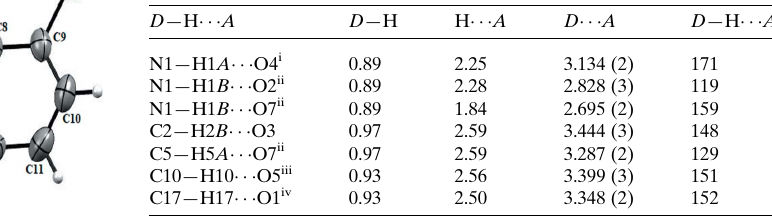
Table 1 Hydrogen-bond geometry (A˚ , (cid:5) ).